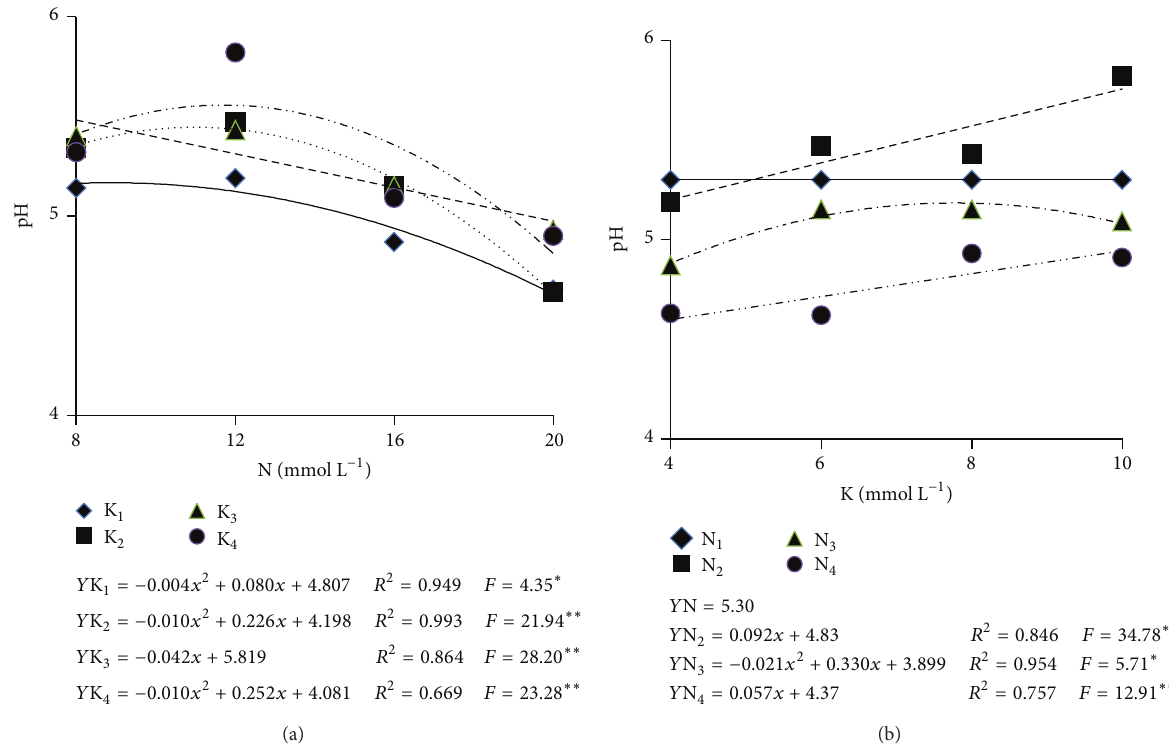
Figure 6: pH values of the substratum solution extract (method 1: 1.5v/v) 60 days after transplantation as influenced by the concentrations of N (a) and K (b) in the nutrients solution. ∗∗ , ∗ : Significant at the levels of 1 and 5%, respectively, according to the 𝐹 test.